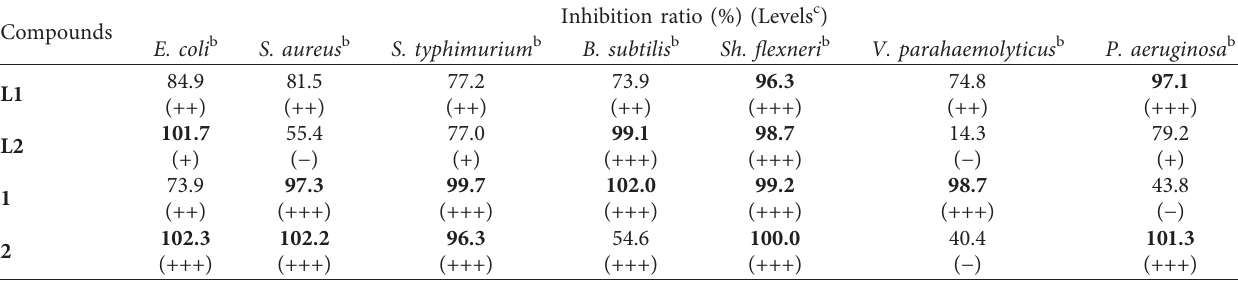
Table 8: Bactericidal activity screening test levels of the ligands and complexes (100 μ g/mL) a .